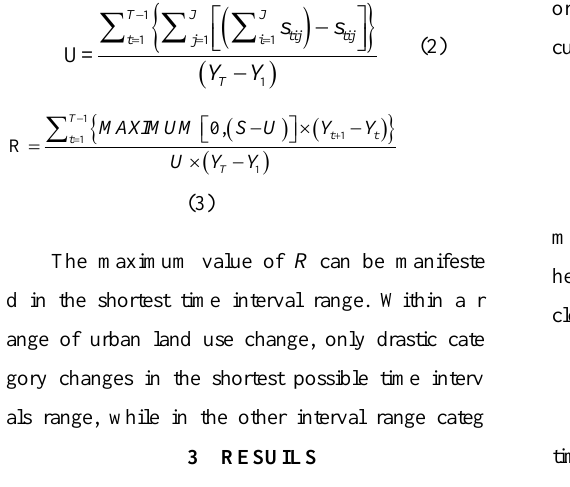
time. In these figures, zero in the legend indicates persistence across the time extent. The maximum value for any pixel in these maps is equal to the number of time intervals.